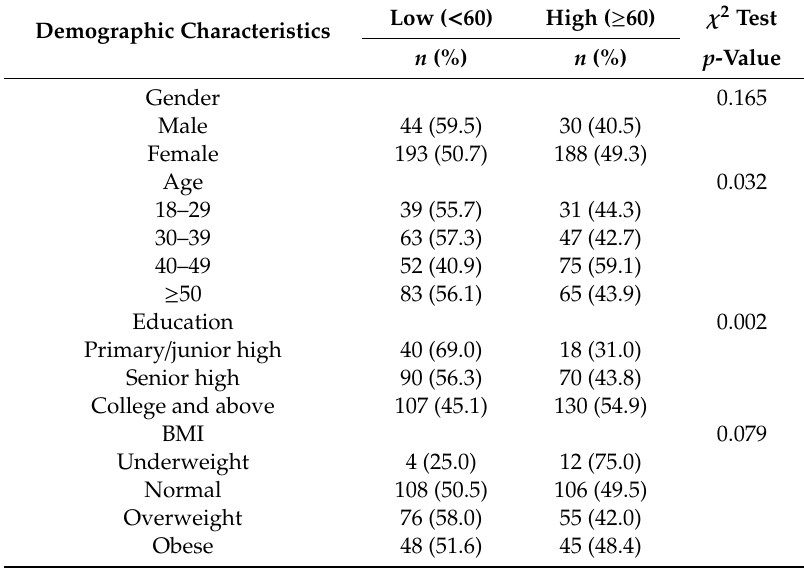
Table 3. Univariate relations of health literacy level and demographic